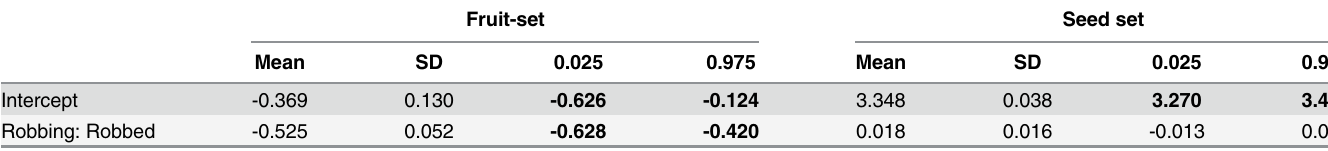
Table 2. Summary of robbing effects on fruit and seed set. The parameters were calculated from the posterior probabilities of the model parameters. Fruit-set Seed set